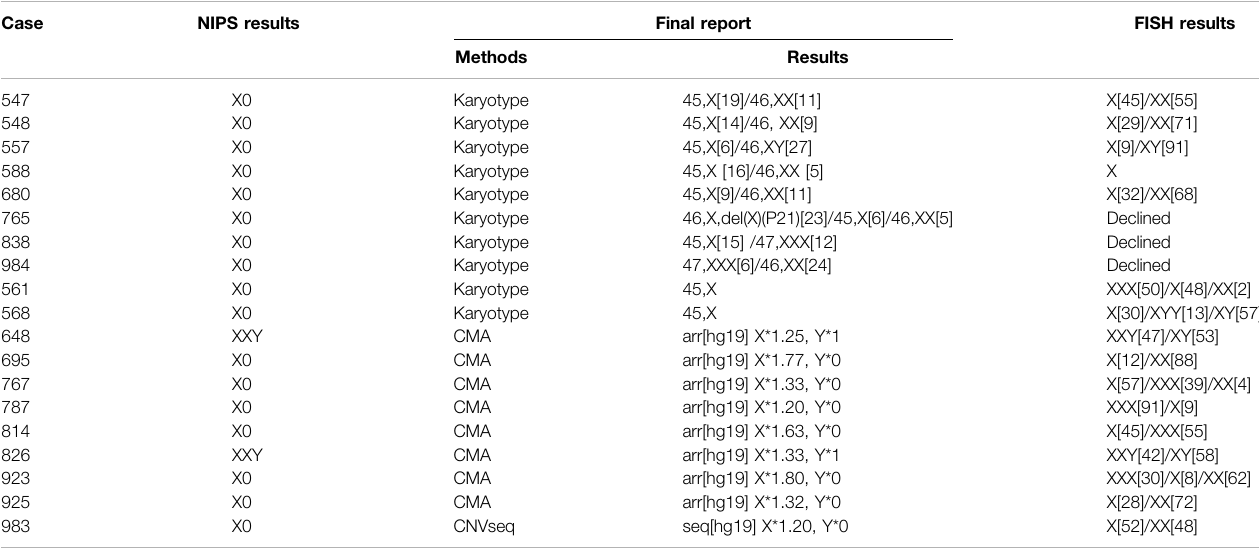
TABLE 4 | Distribution of sex chromosome mosaicism diagnosed